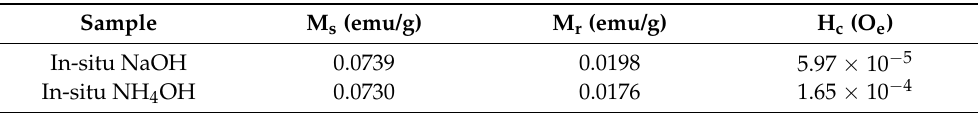
Table 3. The saturation magnetisation (M s ), coercivity (H c ), and retentivity (M r ) of the treated jabon